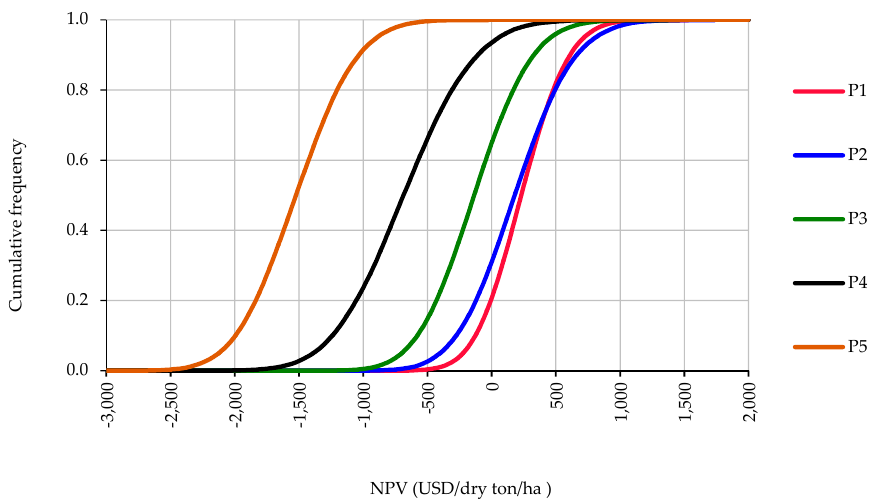
Figure 2. Cumulative probability distributions for alternatives to investment projects in eucalypt forest stands for biomass production.